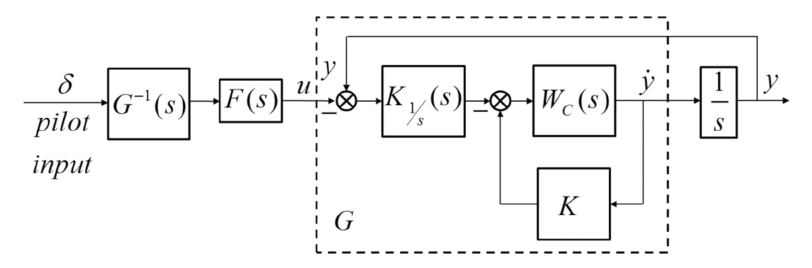
Figure 1. Using inverse